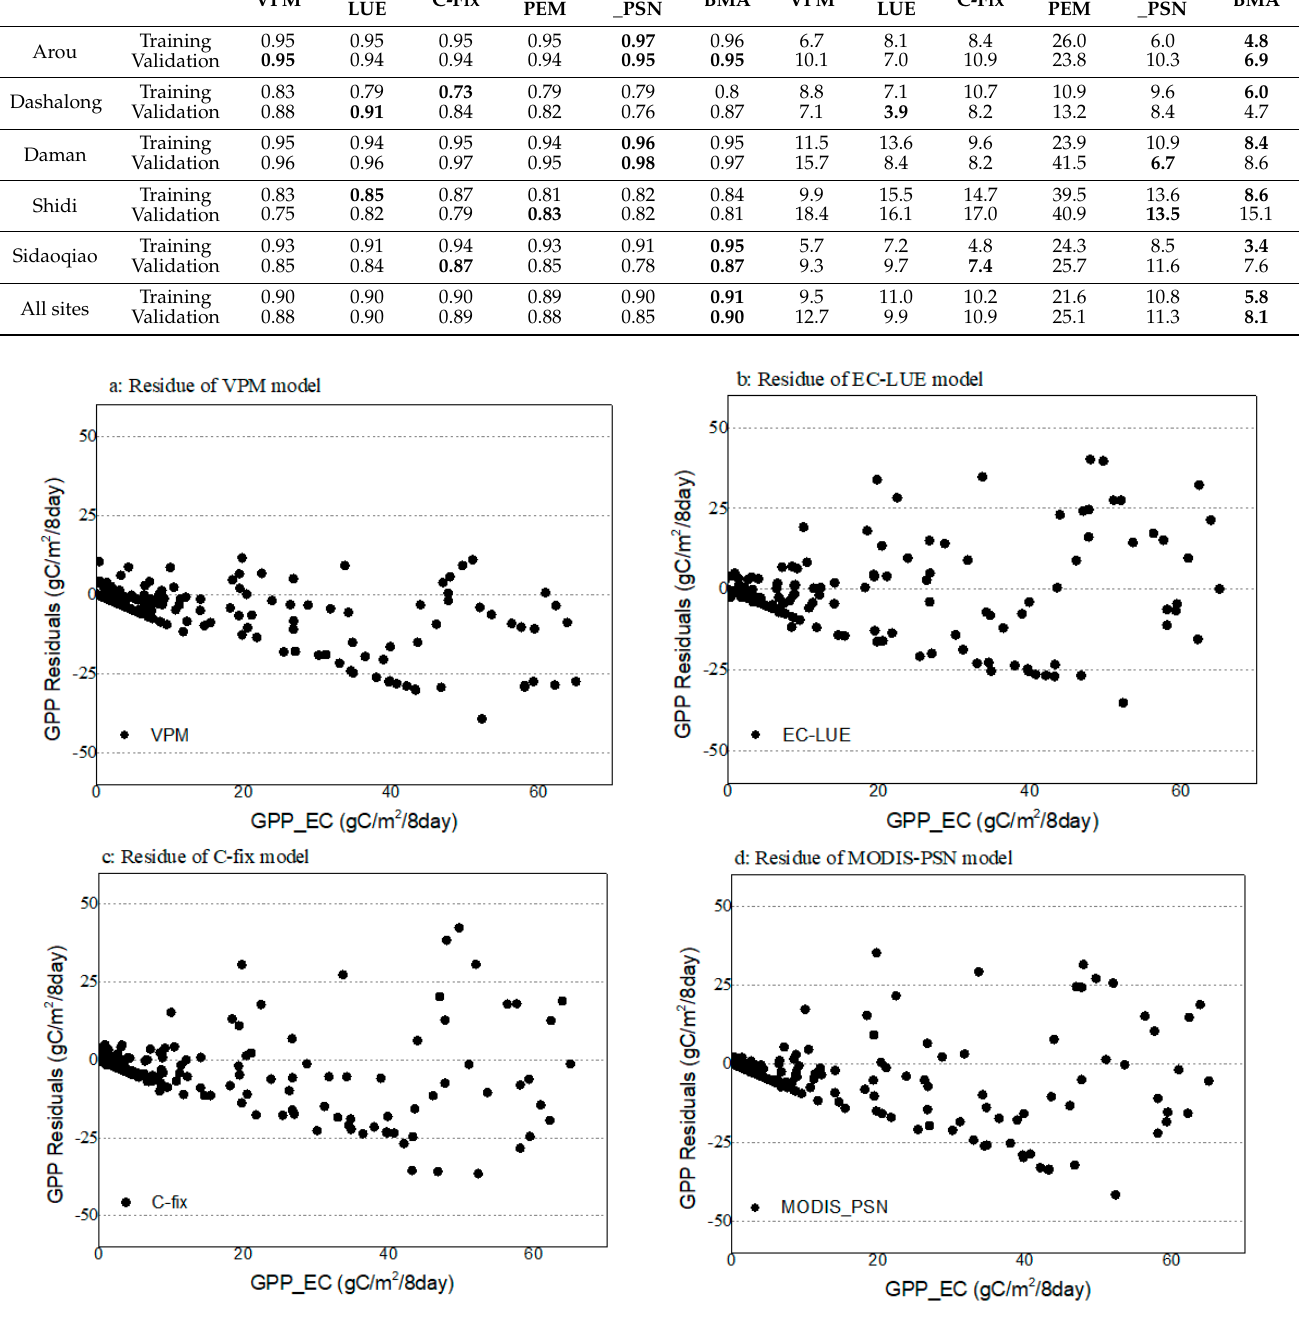
smaller than all the LUE models. All the LUE models had values outside the 1x standard deviation range. Even GLO-PEM and EC-LUE had values outside the 2x standard deviation range. The convergence trajectory of the coefficients for LUE models at the Arou site is shown in Figure 4. The initial coefficients for each LUE model were assigned a fixed value, and the value changed during the iteration and quickly reached a steady-state (Figure 4). Table 4. Determinant coefficients and RMSEs between the simulated GPP and the EC-measured GPP. (Data measured during 2014/2015 was used to train/validate the BMA method. The highest R 2 and the smallest RMSE were bolded.). R Site